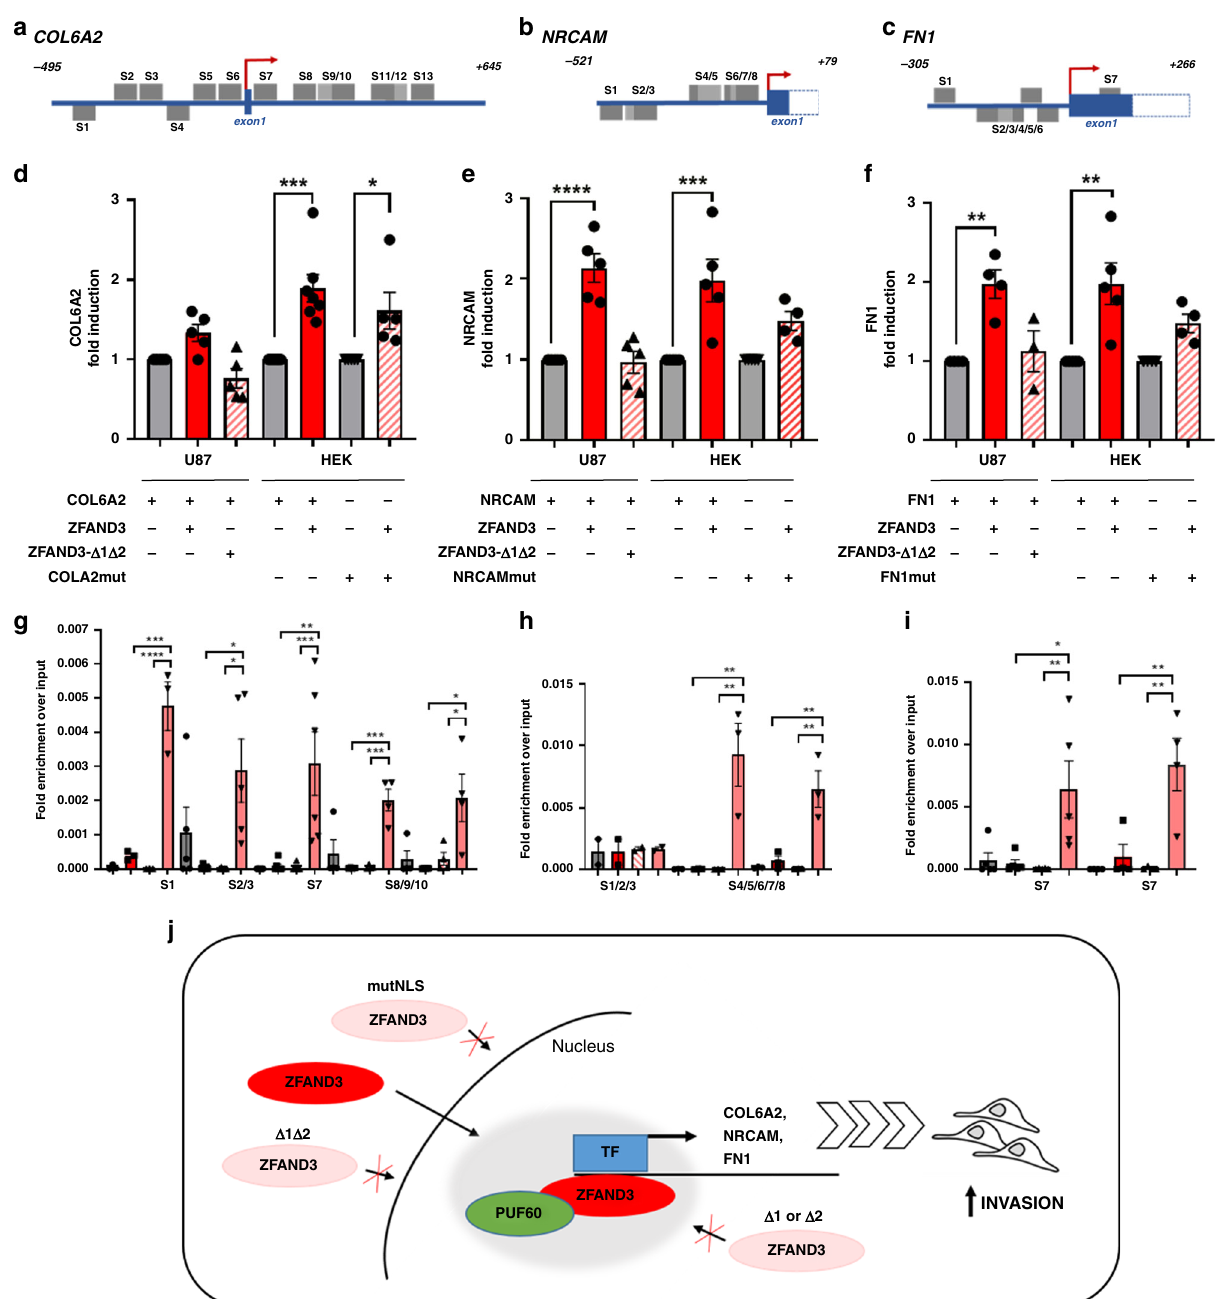
Fig. 7 ZFAND3 binds to and induces promoter activity on COL6A2, NRCAM and FN1 genes. Transcription factor consensus site analysis (via Genomatix) identi fi ed several putative ZF binding sites (GC-rich regions, hereafter named S1-S13) in the promoter regions of COL6A2 ( a ), NRCAM ( b ) and FN1 ( c ). Dual-luciferase reporter assays carried out in U87 or HEK293T cells showed that transiently coexpressed ZFAND3 binds to the promoter regions of COL6A2 ( n ≥ 5) ( d ), NRCAM (n ≥ 4) ( e ) and FN1 ( n ≥ 4) ( f ) inducing luciferase expression, whereas deletion mutant ZFAND3- Δ 1 Δ 2 did not. Luciferase activation was compromised on promoters with mutated GC-rich regions (COLA2mut, NRCAMmut, FN1mut) ( n ≥ 4 biologically independent experiments * p value < 0.05, ** p value < 0.01, *** p value < 0.001, **** p value < 0.0001). ZFAND3 binding to GC-rich regions in the promoter regions of COL6A2 ( n ≥ 3) ( g ), NRCAM ( n ≥ 2) ( h ) and FN1 ( n ≥ 4) ( i ) in HI cells overexpressing ZFAND3 as determined by ChIP qPCR ( n ≥ 2 biologically independent experiments * p value < 0.05, ** p value < 0.01, *** p value < 0.001, **** p value < 0.0001). j Proposed model of ZFAND3 activity in a nuclear protein complex that regulates a gene expression program to trigger cell